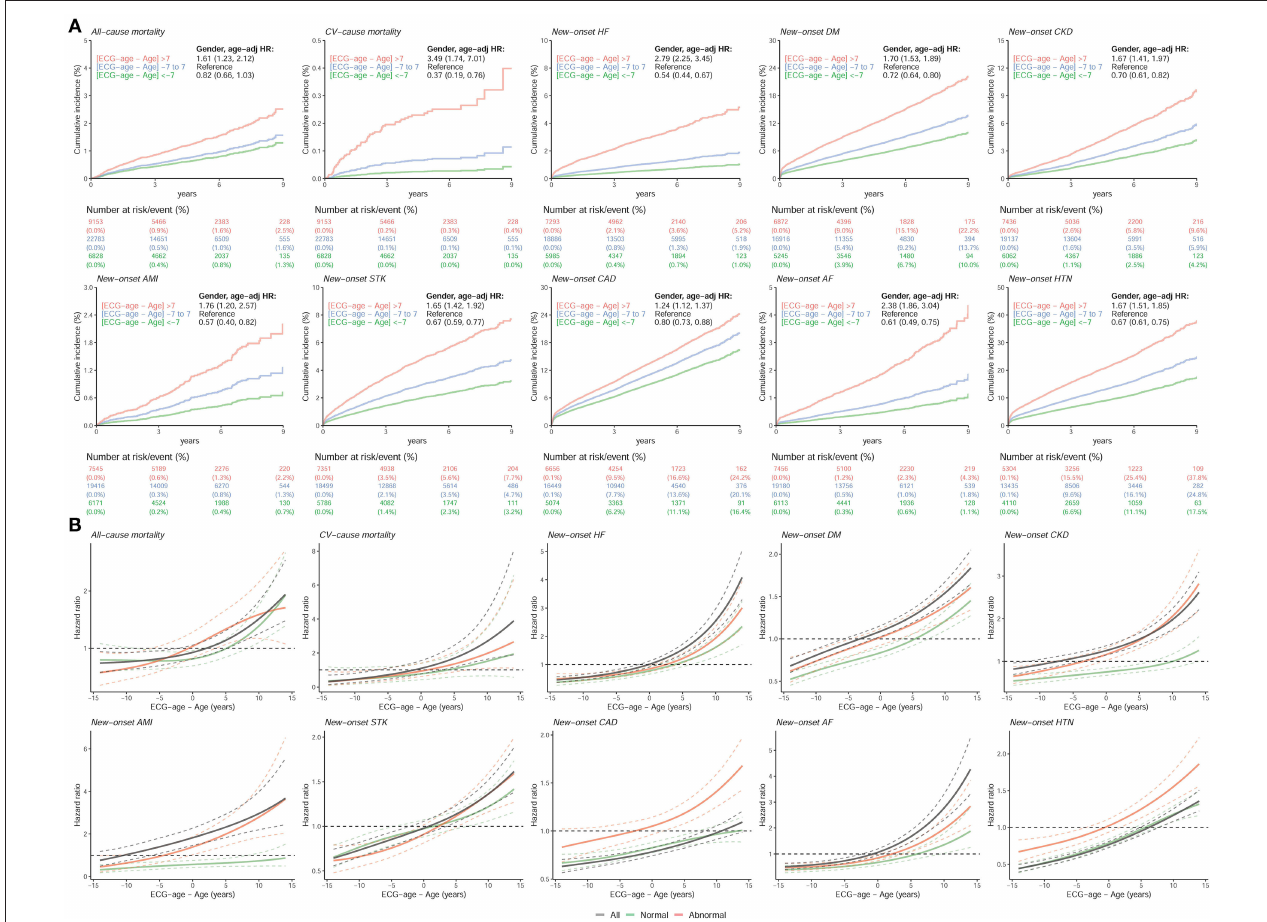
FIGURE 7 | The comparison between higher ECG-age and lower ECG-age for outcomes of interest in validation set. (A) Long-term incidence of developing corresponding adverse event in patients at risk, stratified by the difference between chronological age and ECG-age. The table shows the at-risk population and cumulative risk for the given time intervals in each risk stratification. (B) Continuous association of the difference between chronological age and ECG-age on each outcome. The solid line and dashed line are the point estimation and the corresponding 95% conference interval, respectively. All hazard ratios were adjusted by gender and chronological age. “Normal” refers to the ECGs labeled as normal by the original interpreting physician at the time of ECG acquisition, “abnormal” refers to any ECGs not identified as normal. The black line, green line, and red line represent the risk curve in all ECGs, normal ECGs, and abnormal ECGs,